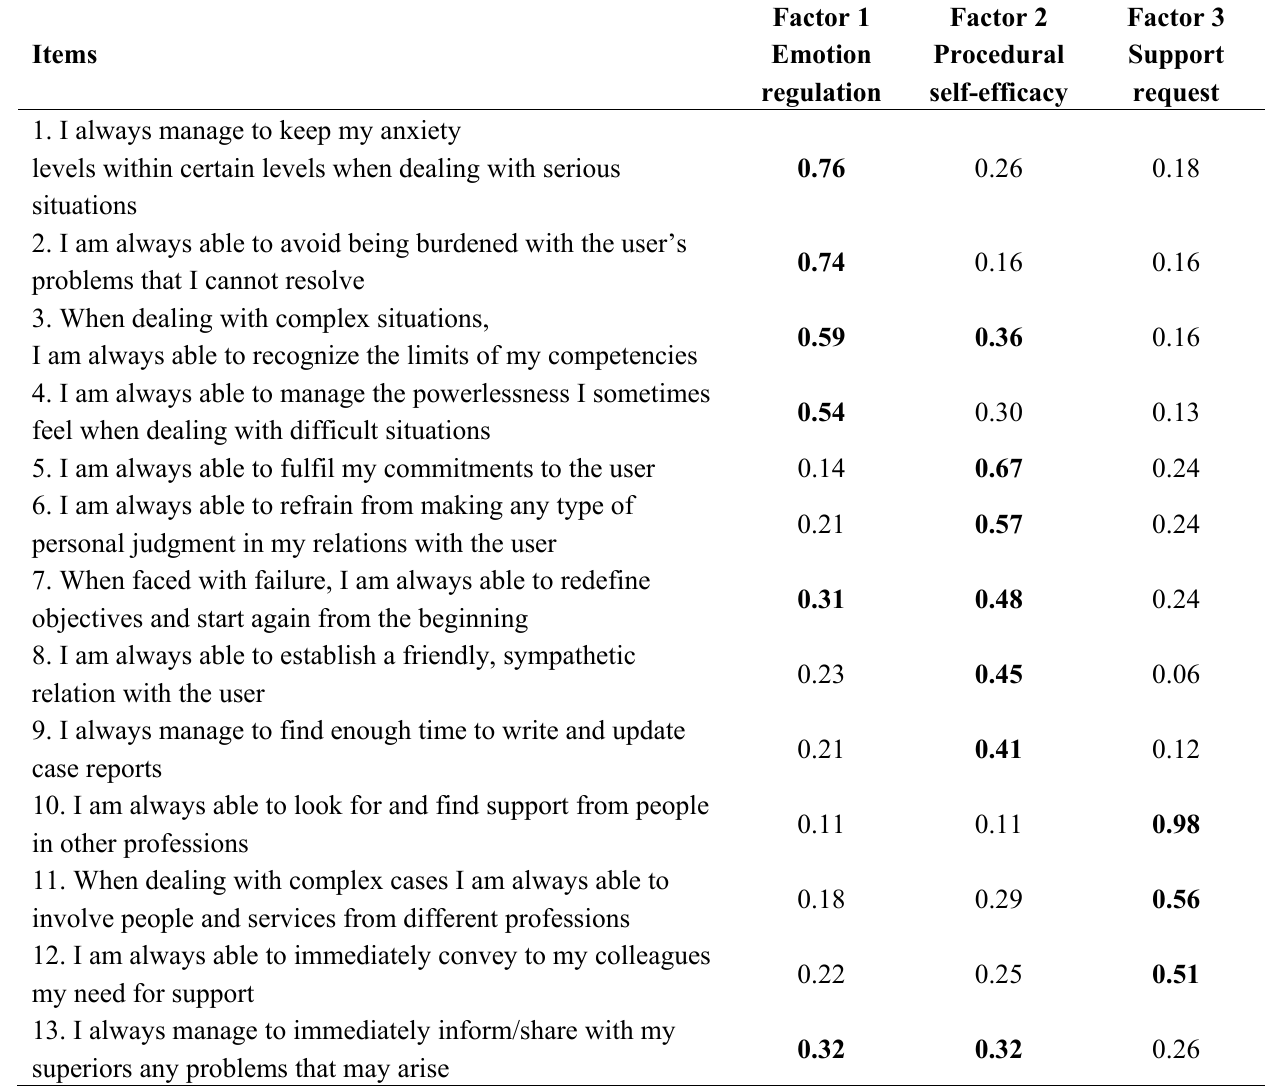
Table 1. Item loadings of exploratory factor analysis